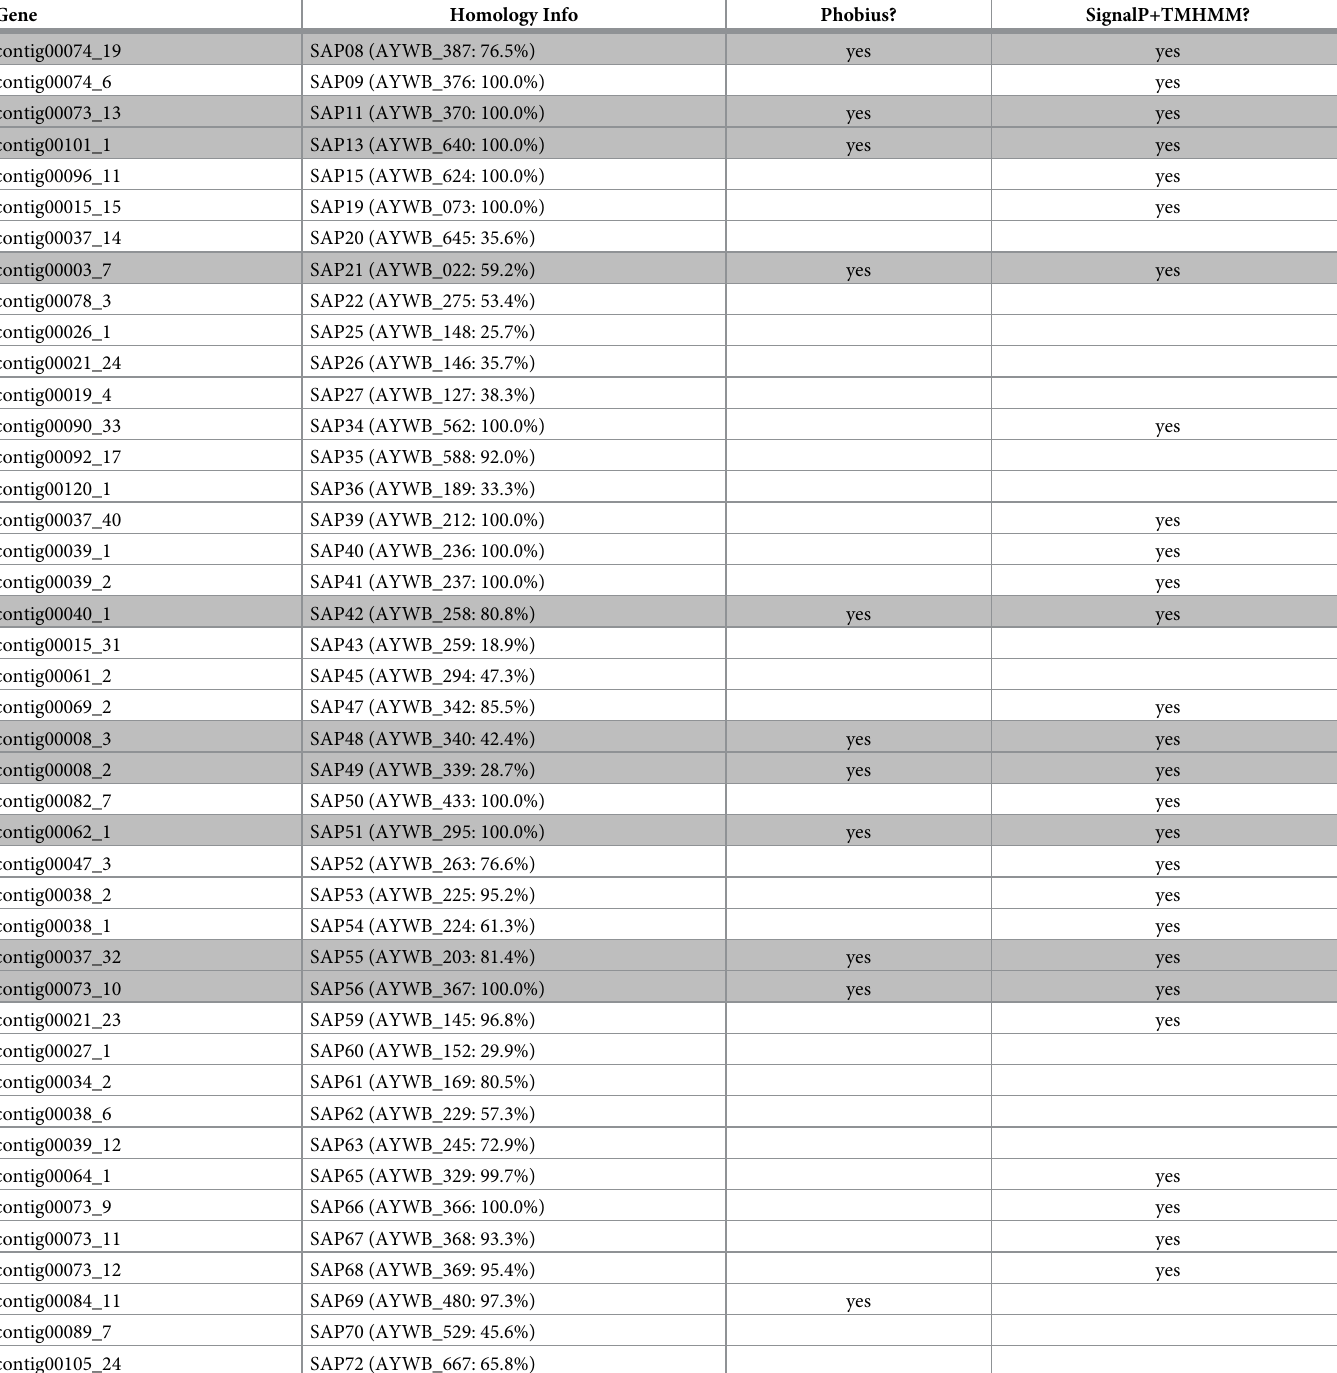
Table 5. Homology-supported candidate NJAY secreted proteins to be released as soluble biomolecules.